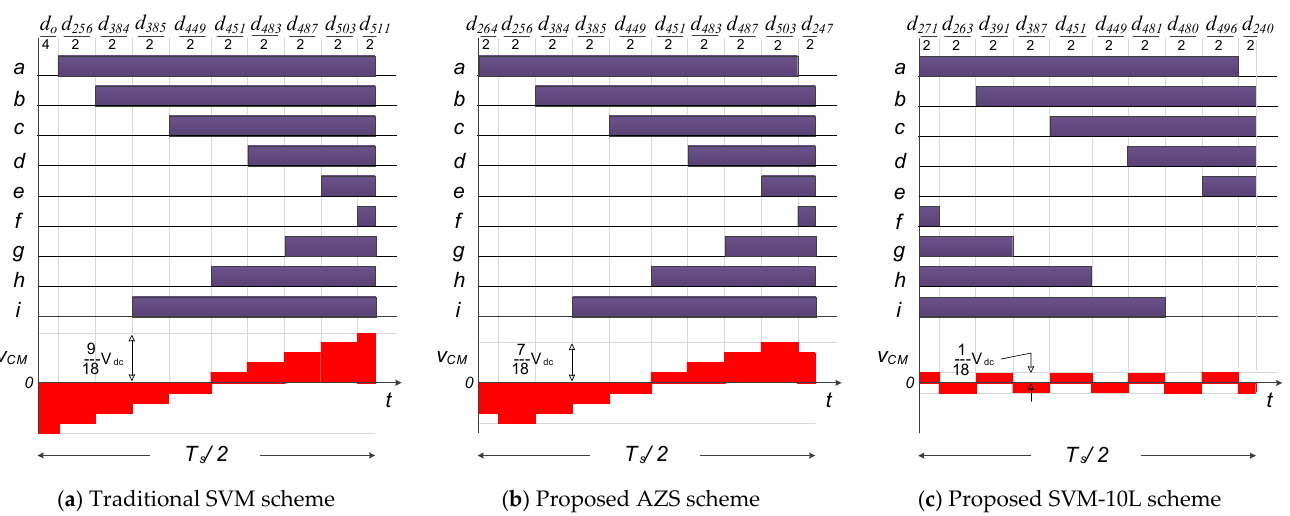
Figure 4. Switching sequence and the corresponding CMV of the selected space vector in sector 1 using traditional and proposed SVM schemes.